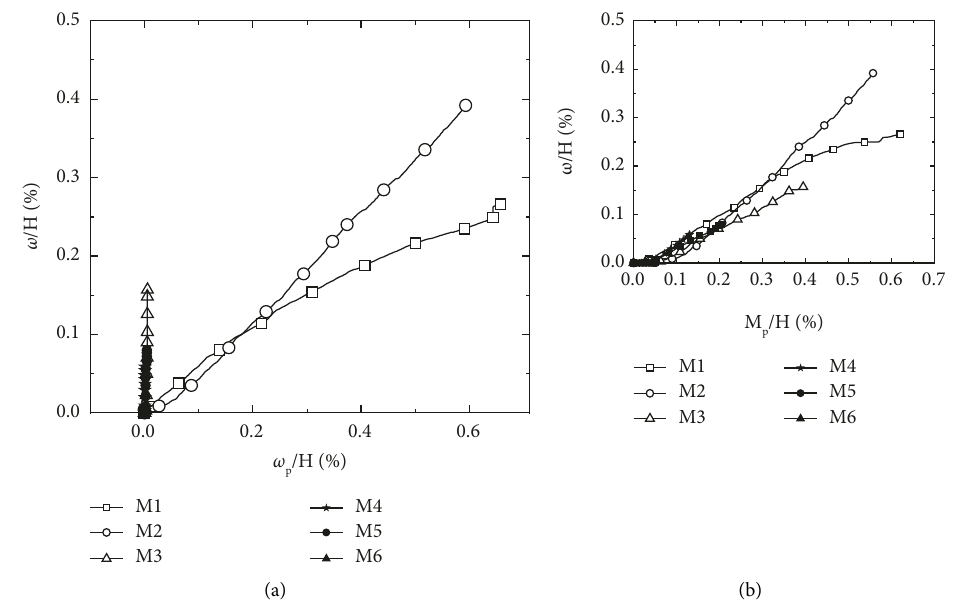
Figure 17: The relationship of settlement at P5 with (a) the settlement ( ω